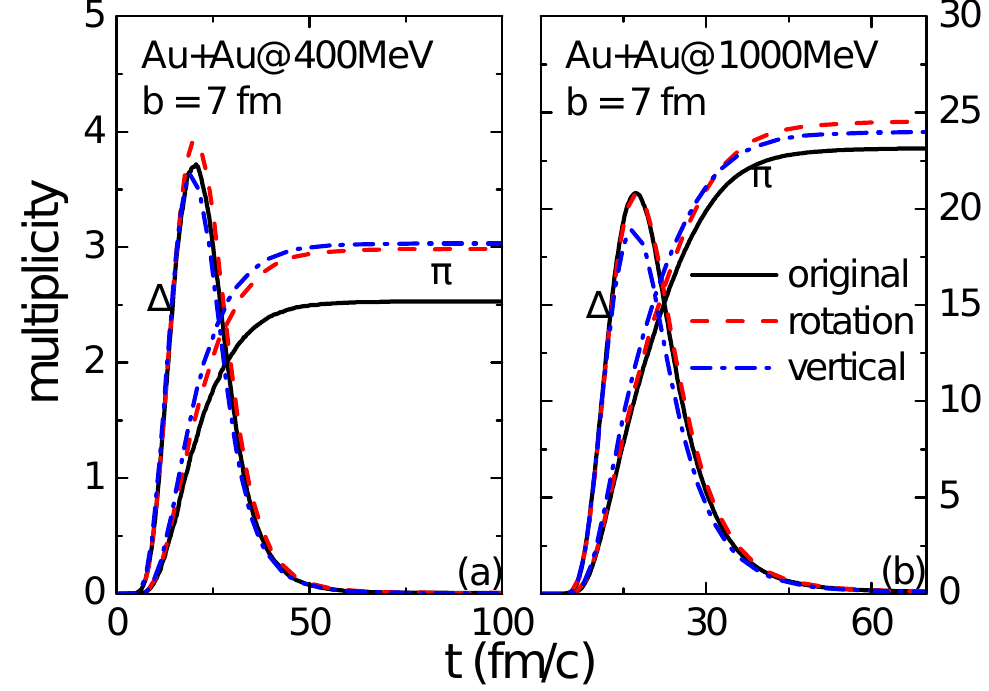
Figure 9. Time evolution of the multiplicities of ∆ resonances and pions from three collision prescriptions in non-central Au+Au collisions at E lab = 400 ( a ) and 1000 ( b )